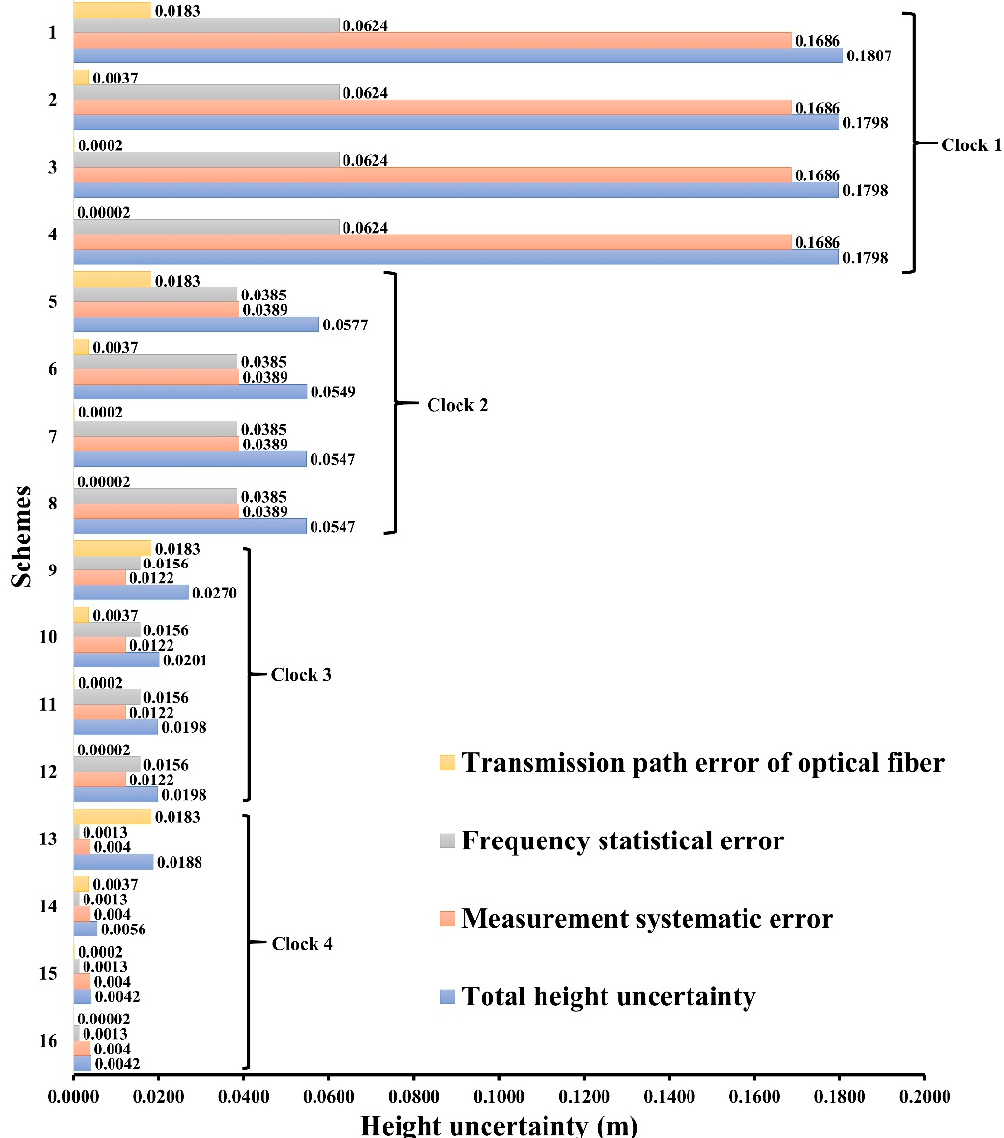
Figure 7. Uncertainty of height measurement for different schemes.